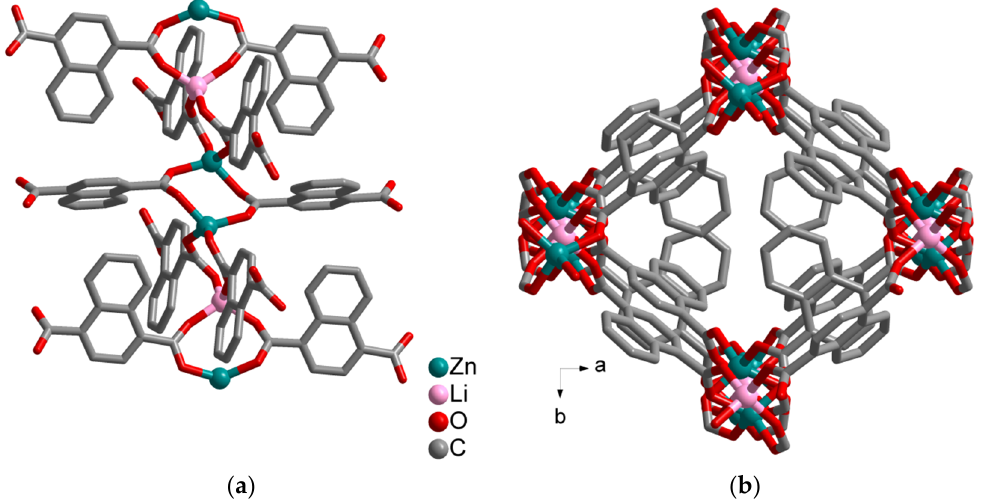
Figure 4. ( a ) Chains in compound 3 ; ( b ) Structure view of 3 along c axis. According to single crystal XRD data compound [{Li 2 Zn 2 (dmf)(py) 2 } {LiZn(dmf) 2 } 2 (NO 2 -bdc) 6 ] · 5DMF ( 4 ) crystallizes in the triclinic space group P –1. There are two types of nodes in this structure: tetranuclear {Li 2 Zn 2 } and dinuclear {LiZn} cores. Tetranuclear cores conserve the structure of the starting complex and even coordinated pyridine as a terminal ligand (Figure 5a). Pivalate moieties are replaced with nitroterephthalate ones. Both Zn